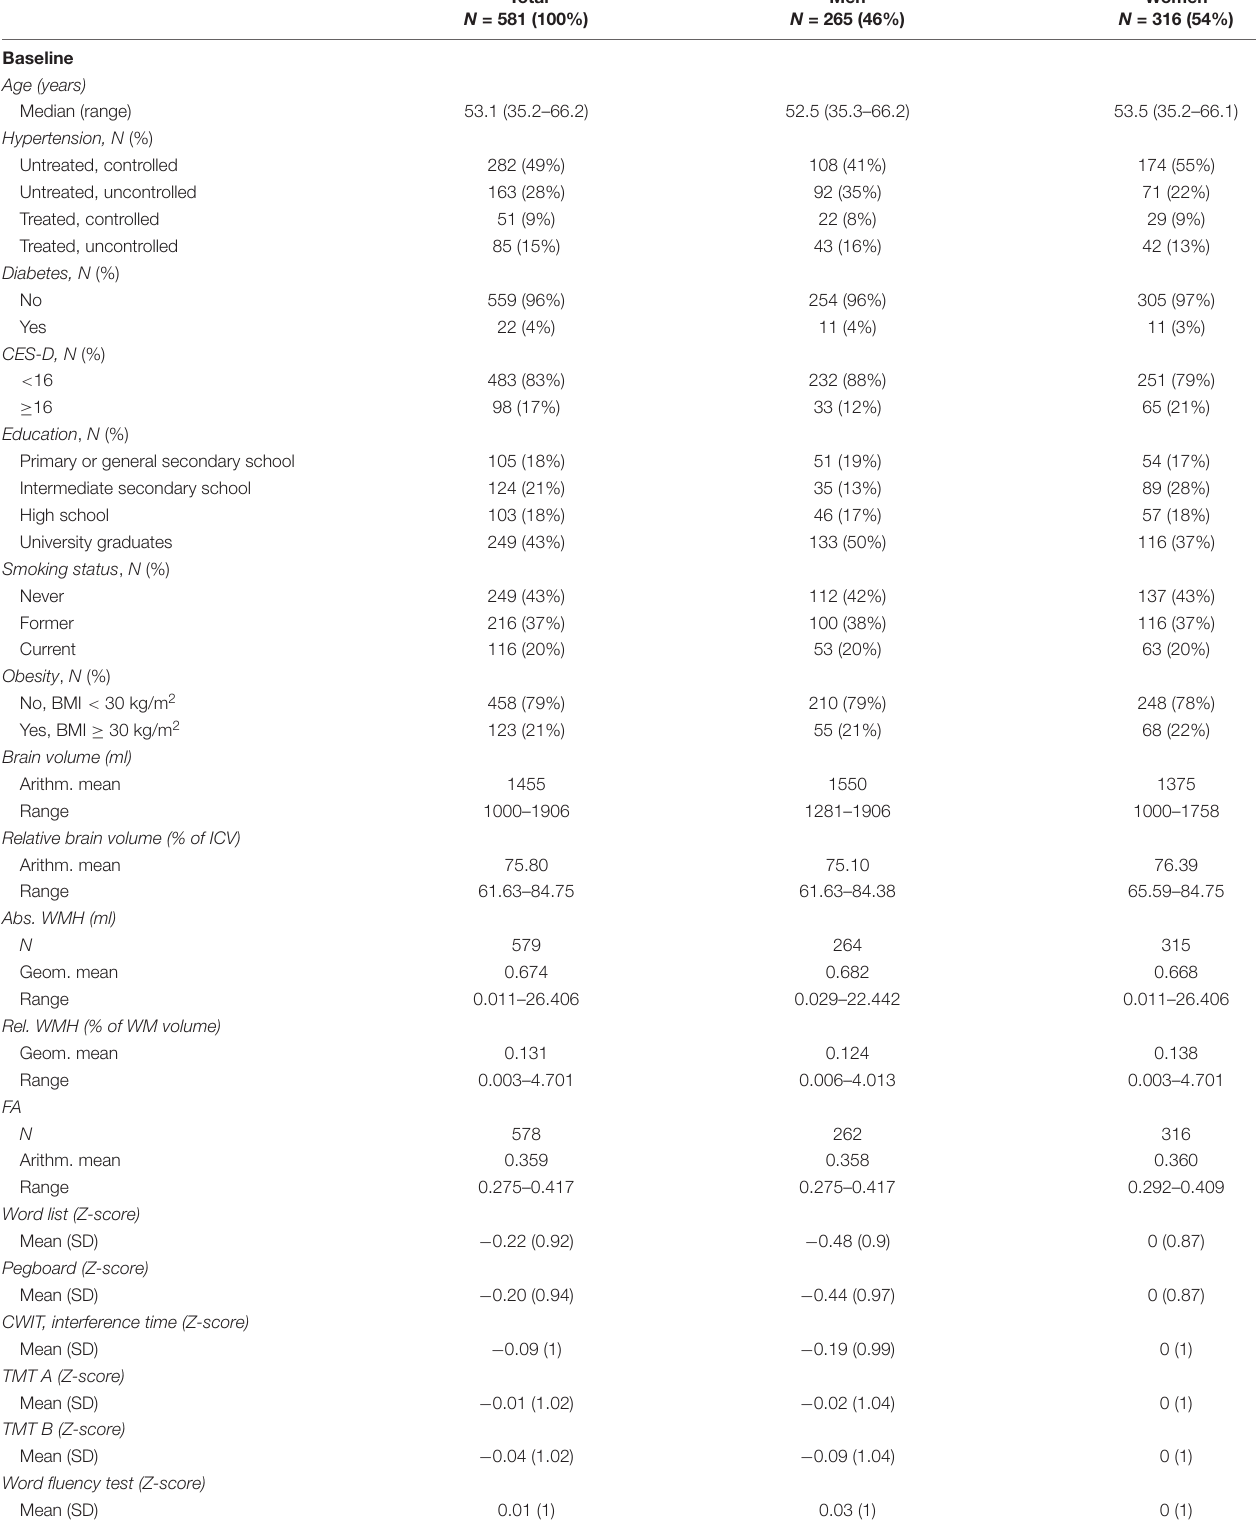
TABLE 1 | Characteristics of study